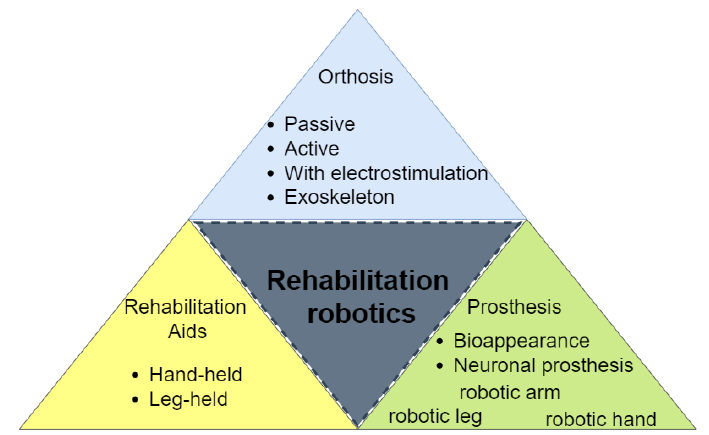
Figure 2. Types of rehabilitation